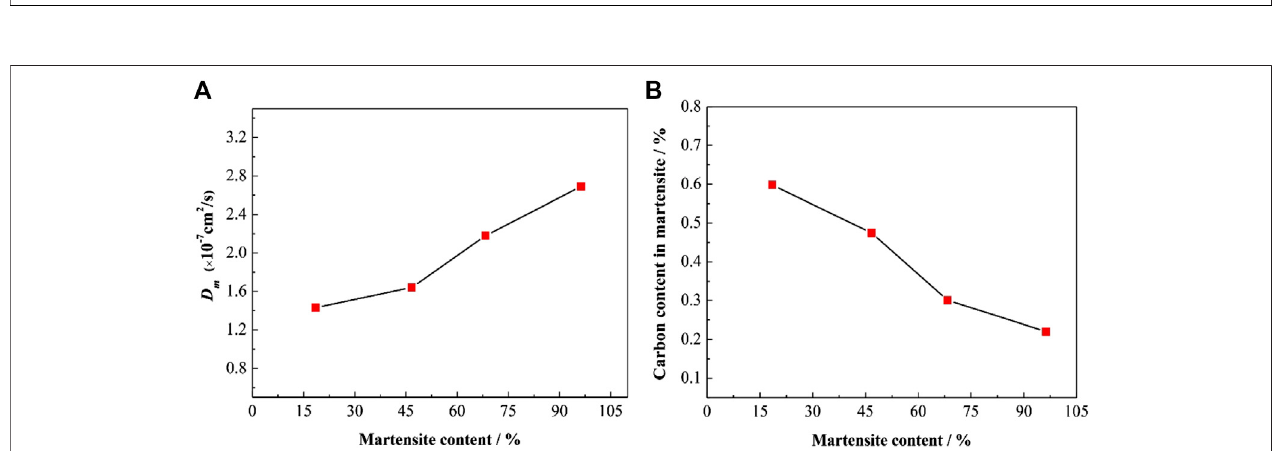
FIGURE11|(A) Desorption curvesofferriticandmartensiticphasesinDPsteelwith46.7%martensite content;and (B) calculatedhydrogen desorptionrateinthe martensitic phase vs time.